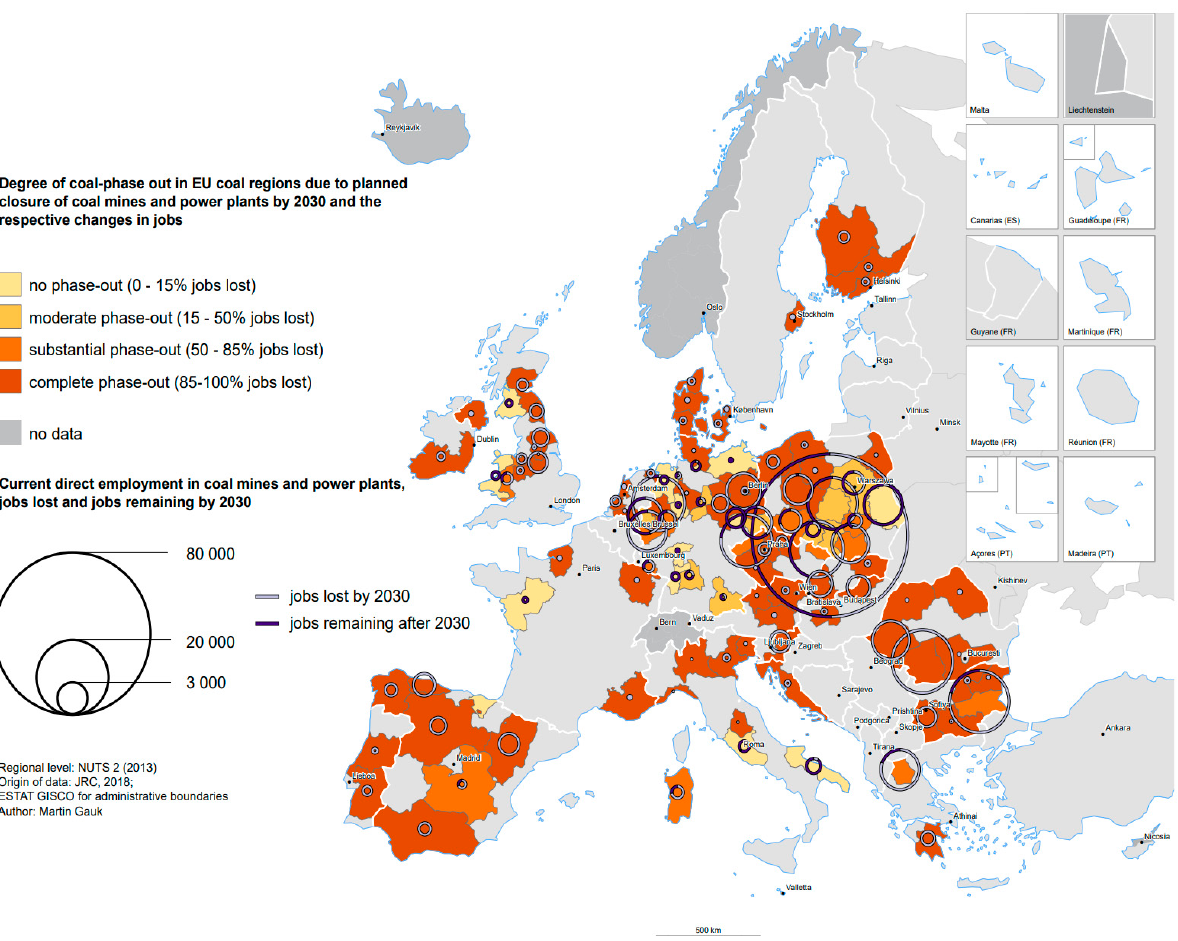
Figure 1. Estimated job losses in coal phase-out regions by 2030. Reprinted with permission from [8] (p. 5).